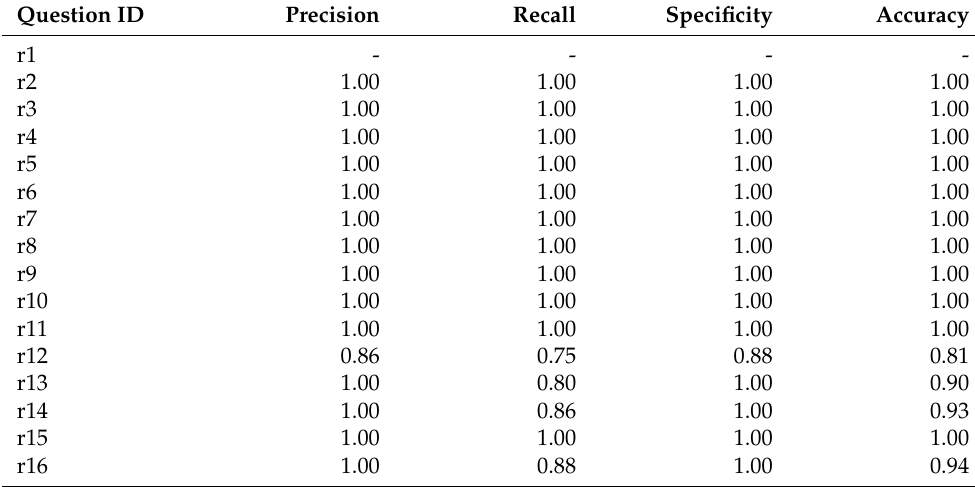
Table 4. Experimental results of extracting fact type in